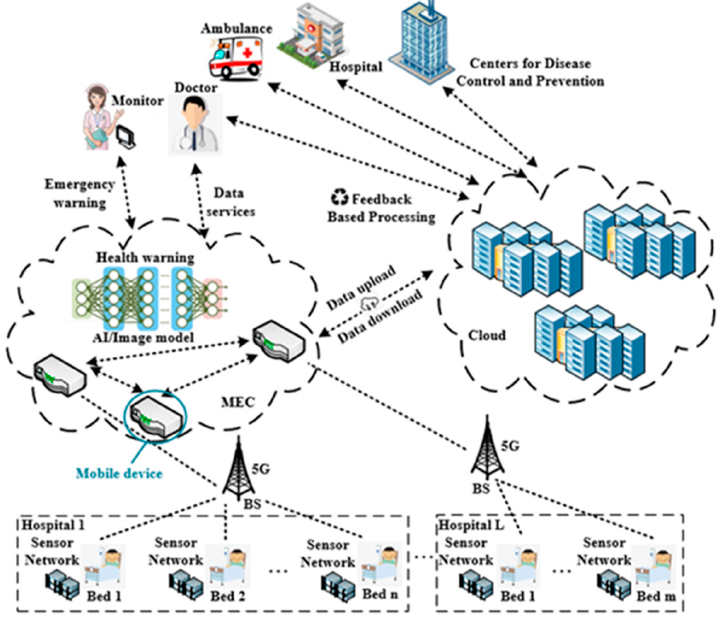
Figure 1. Framework of the system model.